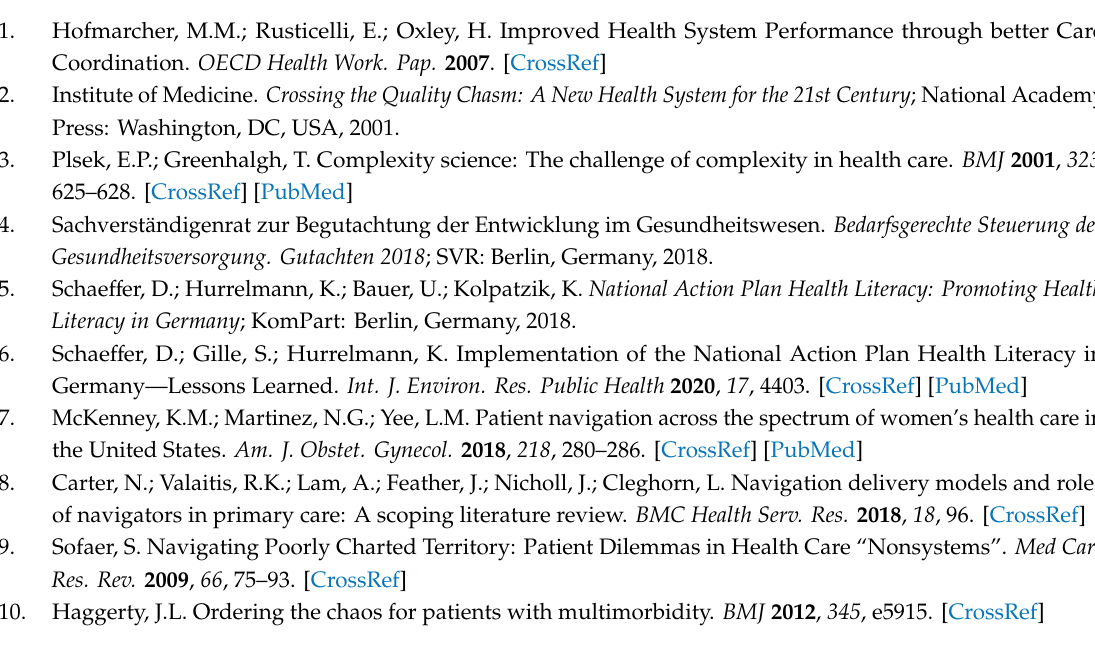
Figure A1. PRISMA flow chart for search